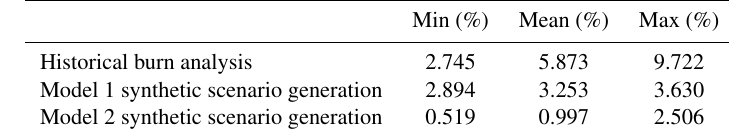
Table 5. Summary of pure risk premiums in terms of percentage of expected crop yields.